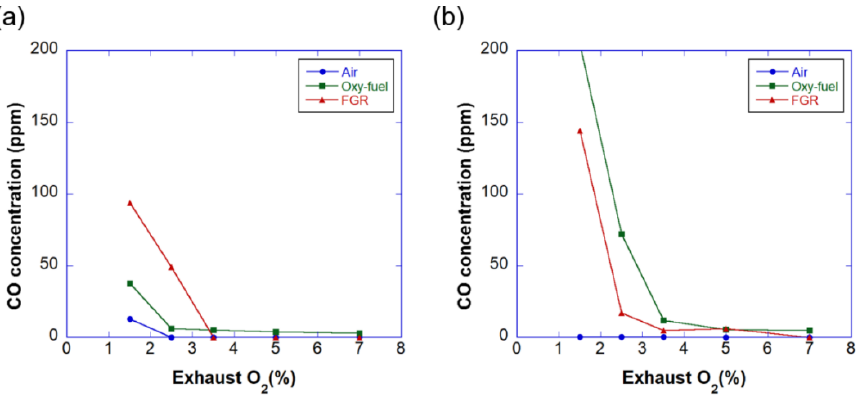
Figure 12. CO emission in parts per million (ppm) at ( a ) 100% and ( b ) 50% loads.